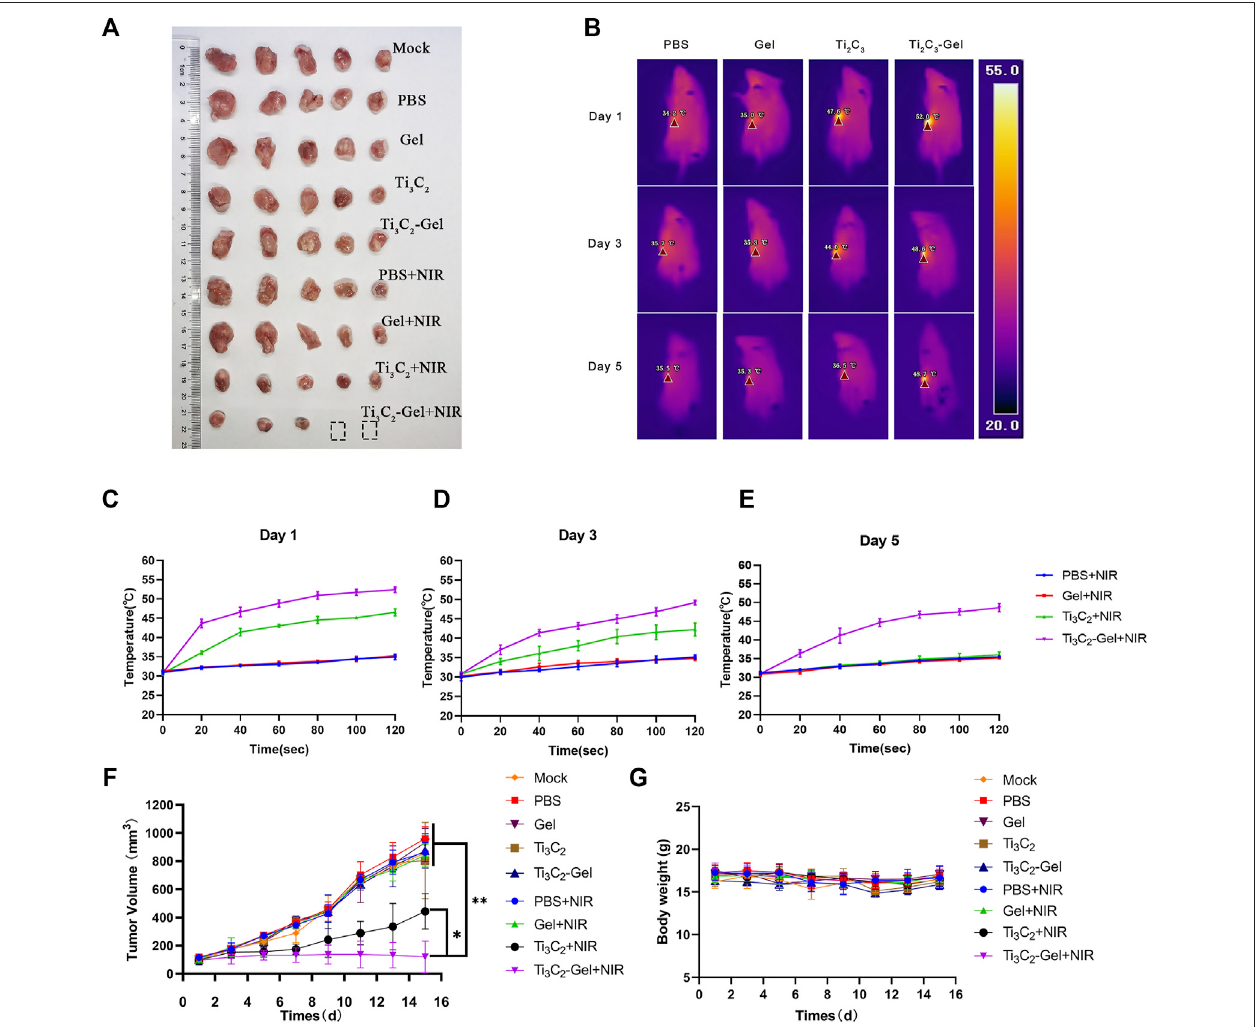
FIGURE 5 | In vivo antitumor performance. (A) Digital images of tumors of mice after treatment. (B) Thermal images of mice irradiated with an 808-nm laser. (C – E) Temperature in tumor-bearing mice recorded by a thermal imager under the 808-nm laser. (F) Growth curves of tumors in all mice after treatment. n (cid:2) 5/group, mean ± SD, ** p < 0.01. (G) Average body weight of mice in different